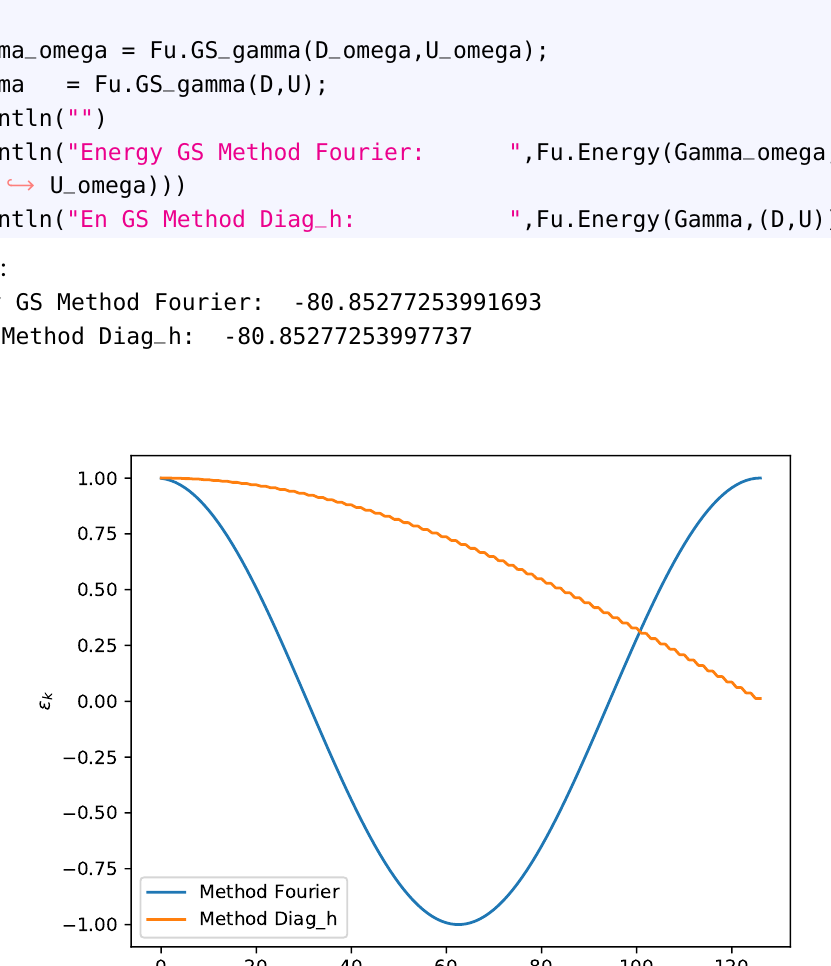
figure("Energies") plot(diag(real.(D_omega))[(N+1):(2*N)],label="Method Fourier"); plot(real.(diag(D))[(N+1):(2*N)], label="Method Diag_h");